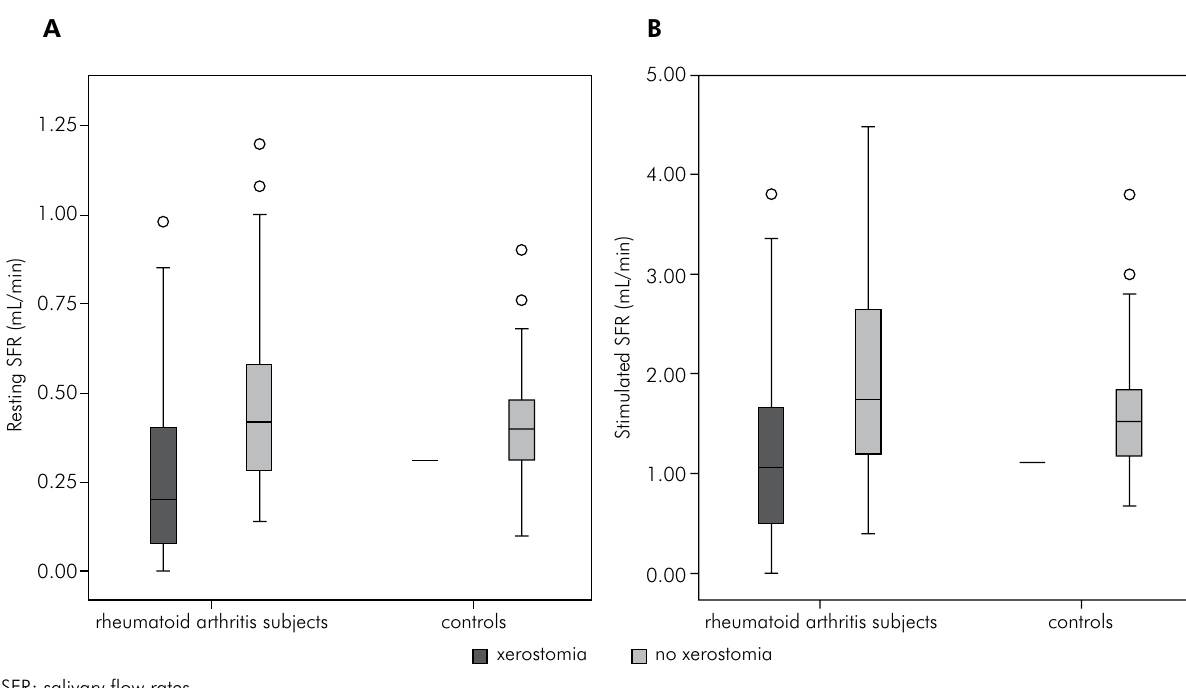
Figure 1. Box-plot graph with the resting (A) and stimulated (B) salivary flow rates of the 145 rheumatoid arthritis subjects separated by the feeling of dry mouth.